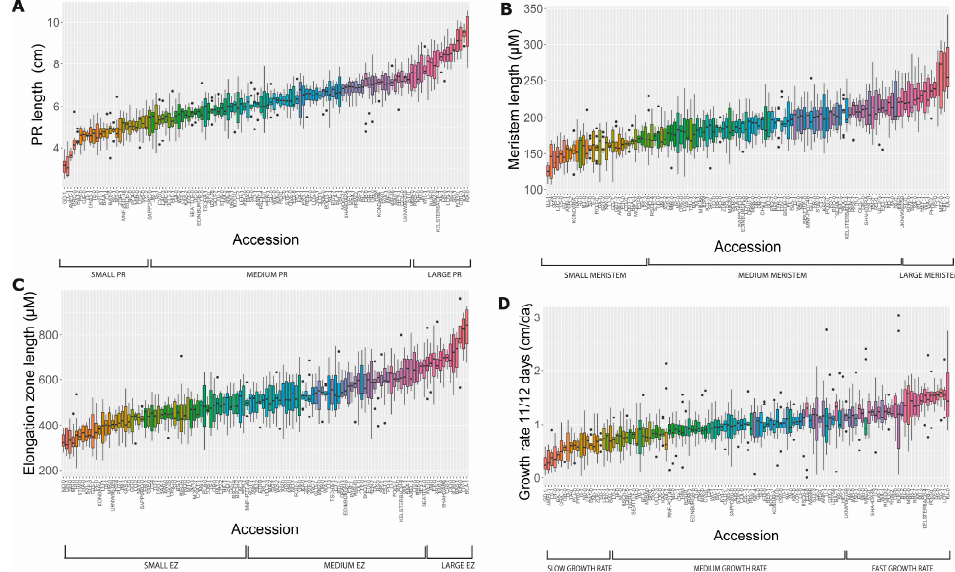
Figure 2. Natural variation of PR traits in the 124 accessions used in this study ( n = 10 seedlings used per accession). The box plot represents the distribution of the PR length at 12 dps ( A ), the meristem ( B ) and elongation zone length ( C ) into small, medium and large. The growth rate from 11 to 12 dps of the accessions is indicated as slow, medium and fast ( D ). The boxes show the first and third quartiles, the vertical line, the median and the whiskers go from each quartile to the maximum or minimum